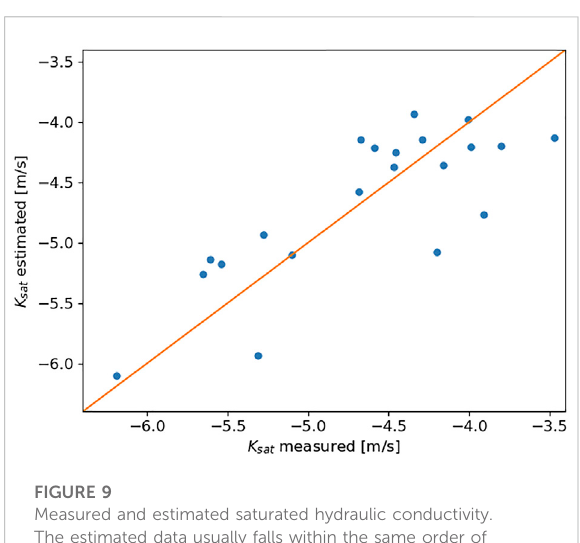
FIGURE 9 Measured and estimated saturated hydraulic